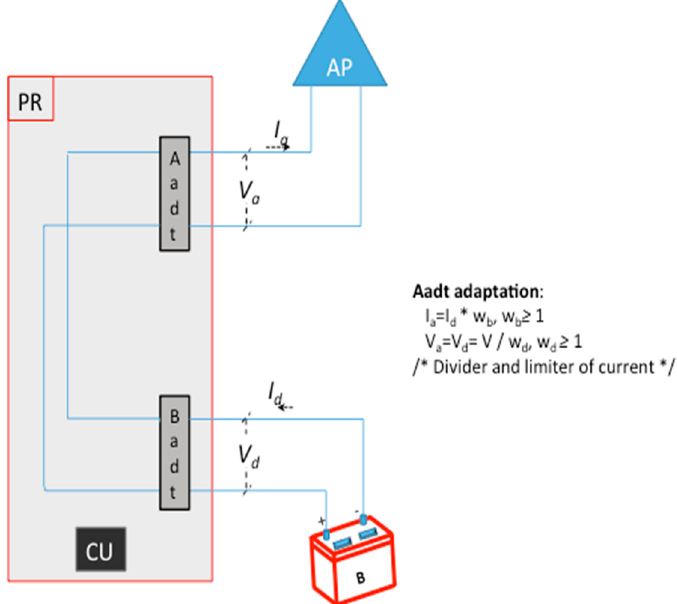
Figure 4. Graphic and formal model of our system with our mechanism working in the discharge period.